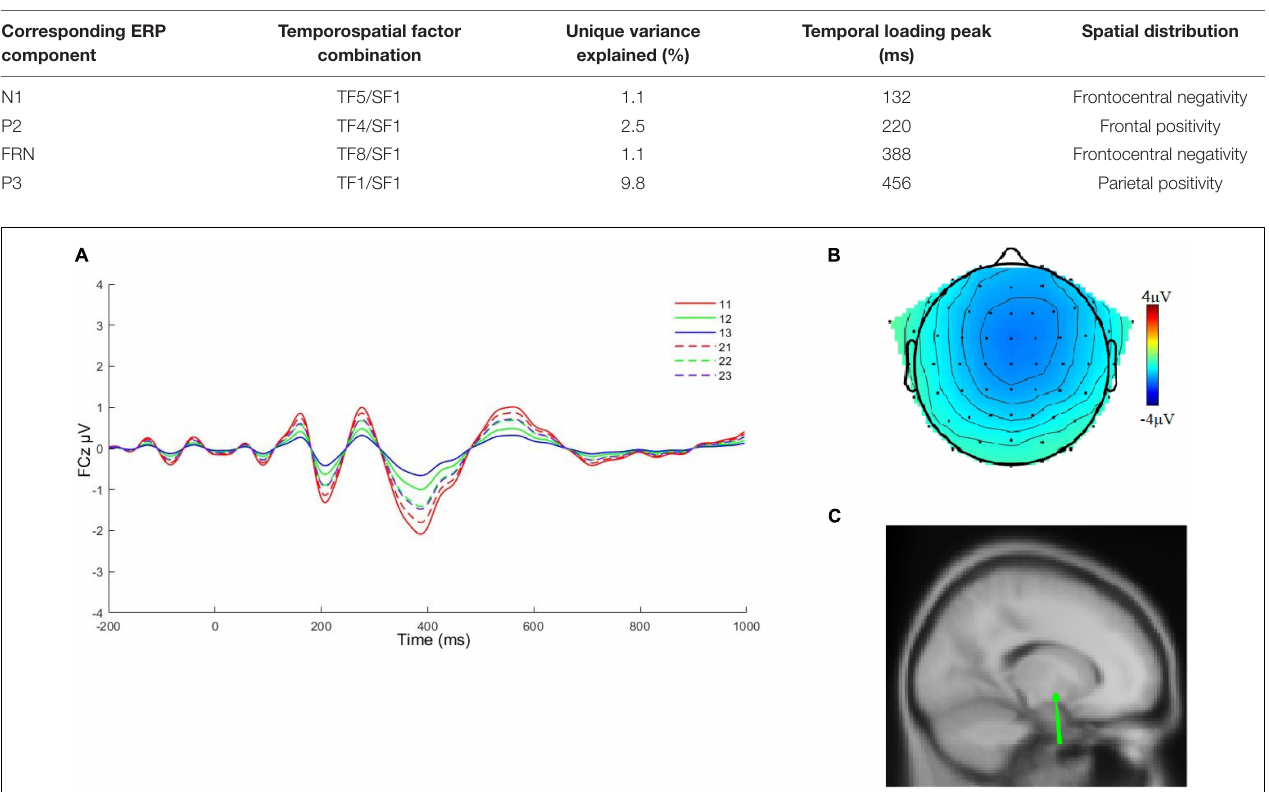
FIGURE 3 | (A) The average waveform of the feedback negativity at FCz for six conditions. 11: ingroup, extremely unfair; 12: ingroup, moderately unfair; 13: ingroup, fair; 21: outgroup, extremely unfair; 22: outgroup, moderately unfair; 23: outgroup, fair. (B) Topography of deaf college students in the face of extremely unfair conditions. (C) The dipole source associated with time factor 8/spatial factor 1 (TF8/SF1).